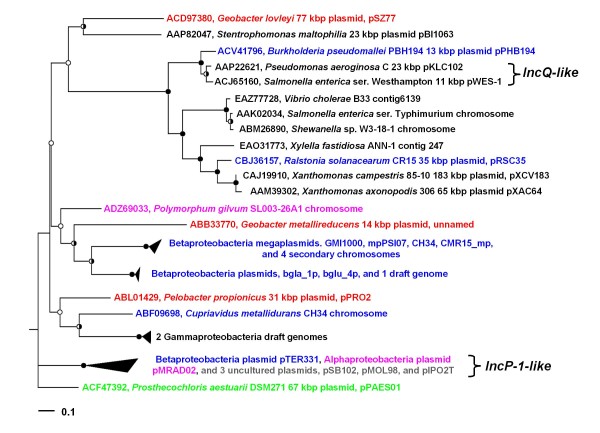
Unrooted proML tree of 35 plasmid replication initiator protein (RepA) sequences aligning with pSZ77 RepA in PSI-BLAST. The majority of RepA sequences in the tree are either from the β-Proteobacteria (blue, 15 in all) or the γ-Proteobacteria (black, 11 in all). Also represented are α-Proteobacteria (magenta) and Chlorobi (green). The SZ/KB-1 RepA (red) do not cluster with the other two δ-Proteobacteria RepA (red) suggesting a possible origin of the pSZ77 replicon region outside of the δ-Proteobacteria. Several of the RepA are chromosome-encoded, suggesting origins from mobilizable plasmids such as IncQ. The bootstrap values at each node with >90% support, 50–90% support and <50% support are indicated by black, half-shaded, and white circles, respectively. The scale bar indicates substitutions per site (0.1 = 1 in 10 amino acid residues).